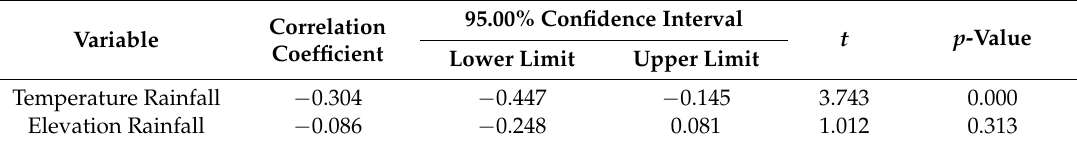
Table 5. The main effects of rainfall values for all stations (Temperature and Elevation).